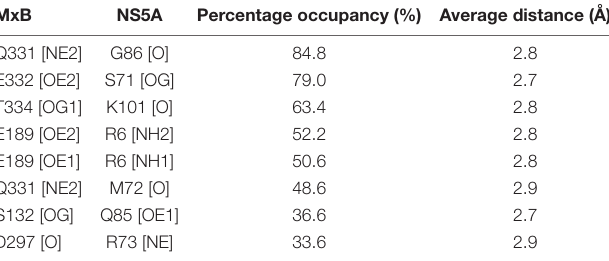
TABLE 1 | H-bond analysis for MxB:NS5A protein–protein